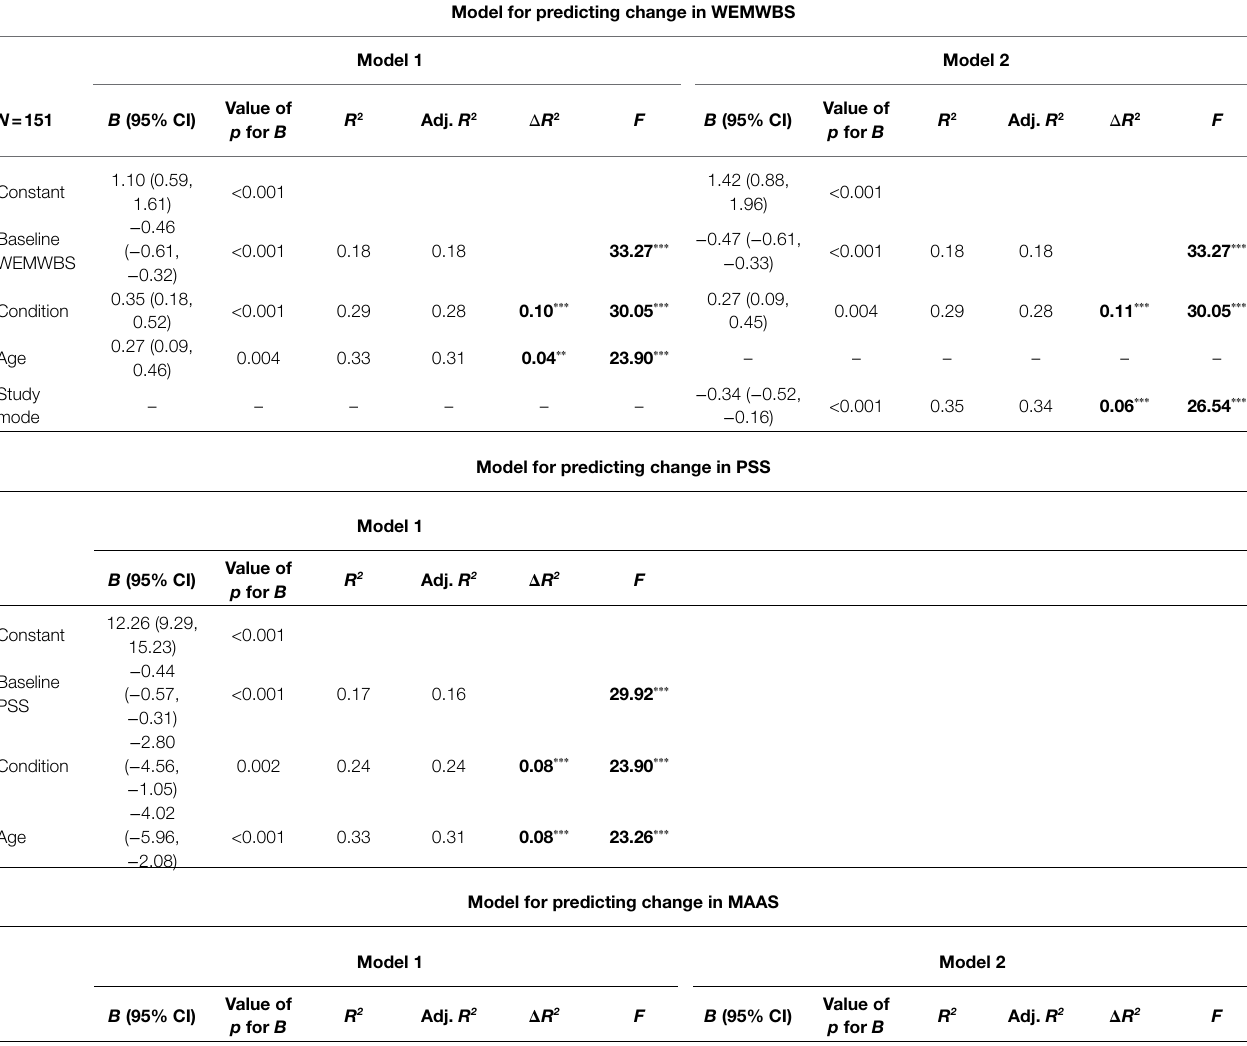
TABLE 4 | Models predicting change in wellbeing, stress and mindful attention. Model for predicting change in